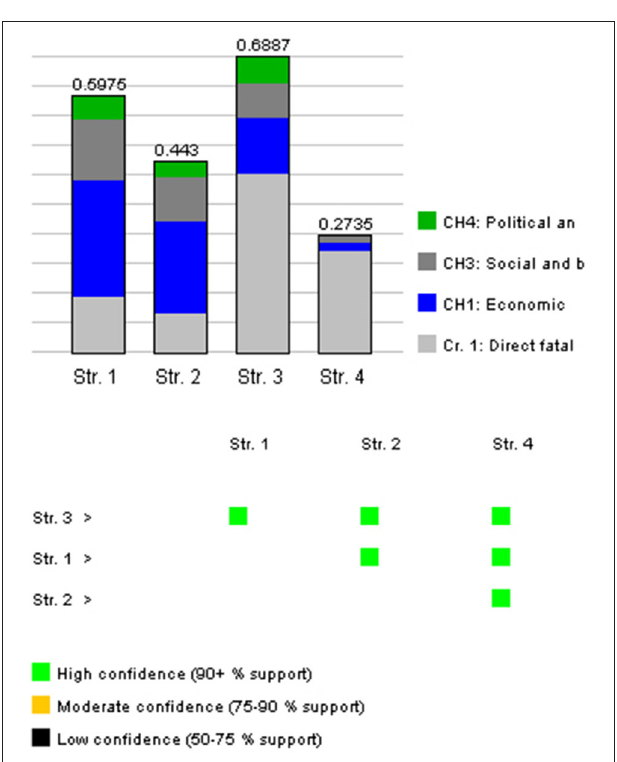
FIGURE 6 | The result of the DecideIT evaluation showing ranking, the criteria contribution as well as the significance of the result.